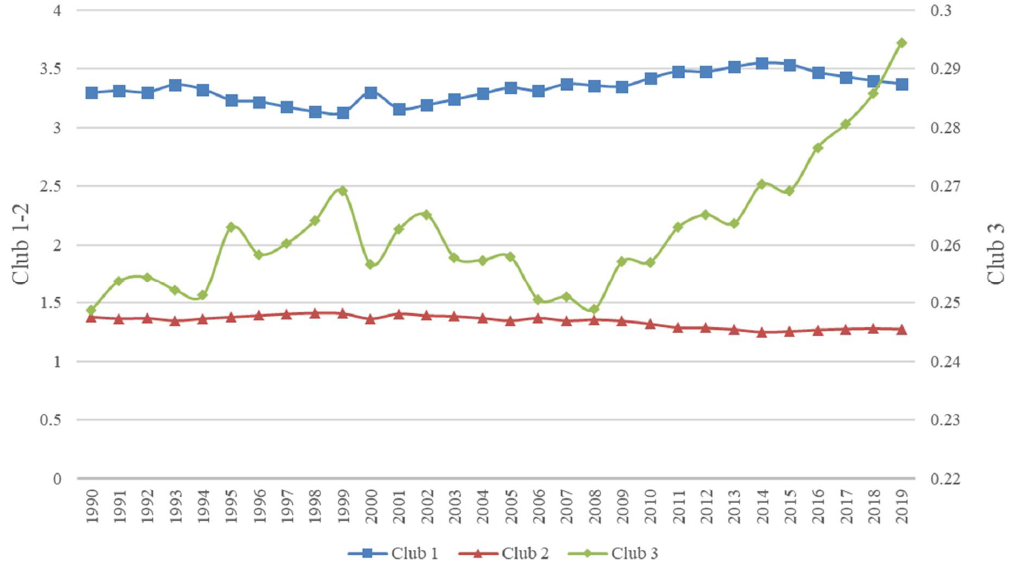
Figure 1. Relative transition path curve of convergence clubs.